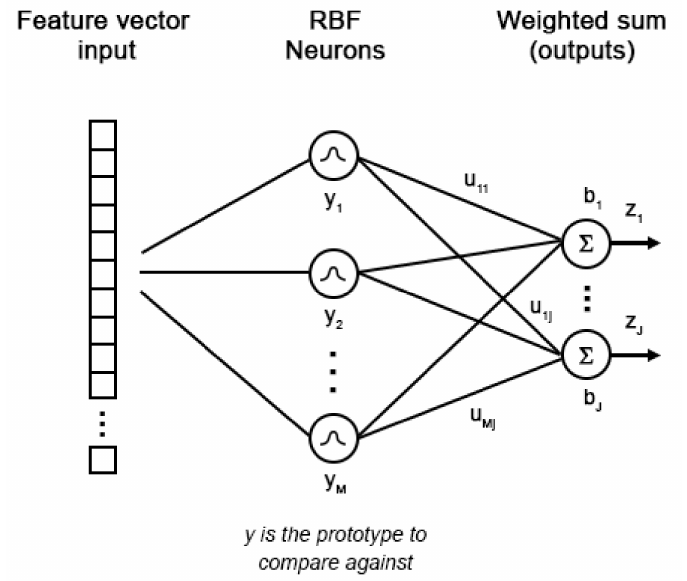
Figure 1. Architecture of a standard radial basis function neural